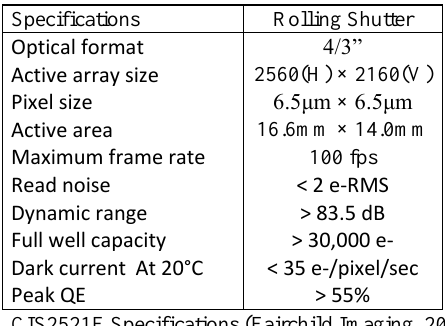
Table 1. CIS2521F Specifications (Fairchild Imaging, 2015)